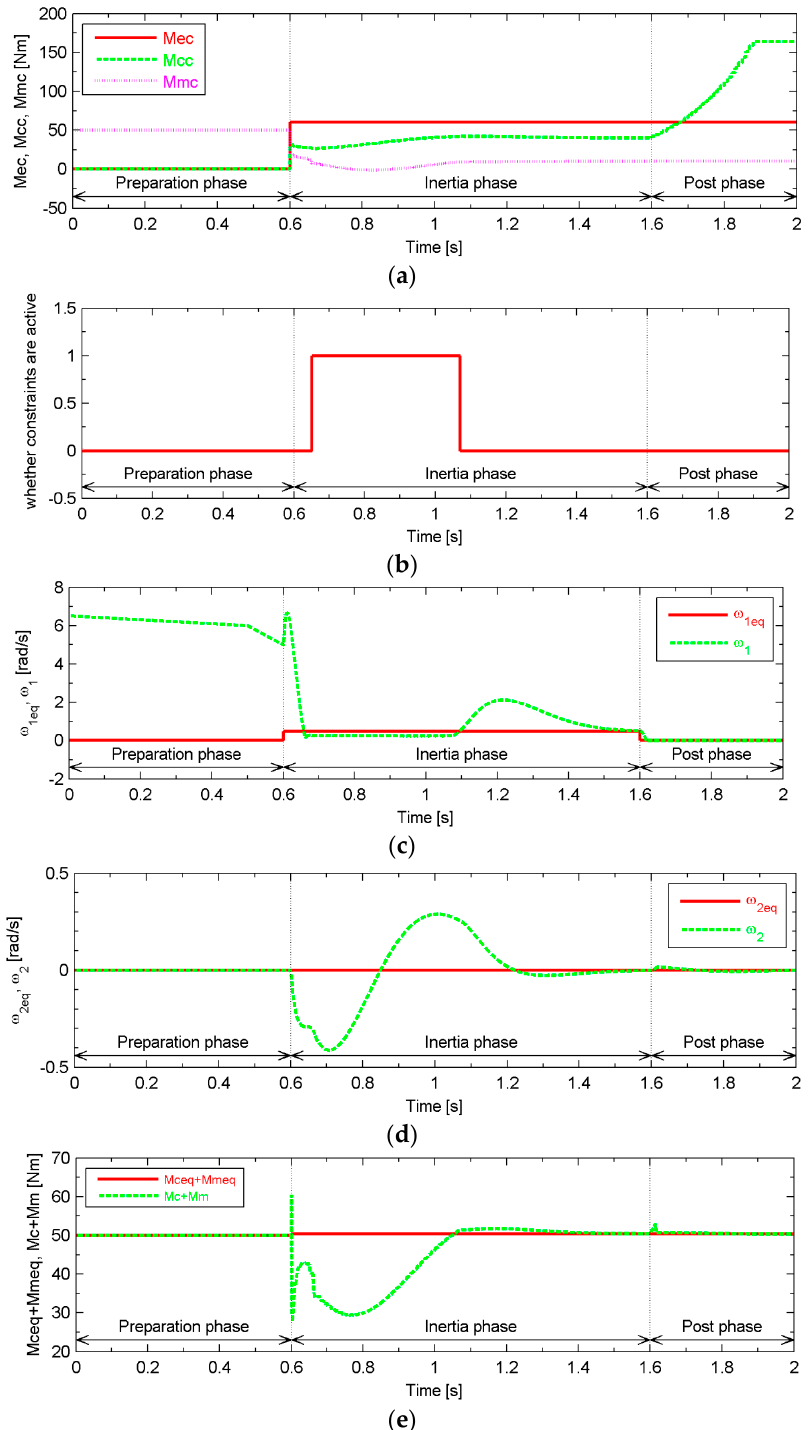
Figure 9. Performance in nominal conditions with a 1 = a 2 = 0.9, N 1 = N 2 = 5, Q 1 = I 3 × 3 and R = I 2 × 2 . ( a ) Engine output torque command M ec , clutch torque command M cc and motor output torque command M mc ; ( b ) Conditions of the constraints; ( c ) Equilibrium state of the clutch sliding speed ω 1 eq and clutch sliding speed ω 1 ; ( d ) Equilibrium state of the time derivative of torsion of the axle shaft ω 2 eq and time derivative of torsion of the axle shaft ω 2 ; ( e ) Torque demanded by the driver M ceq + M meq and torque supplied by the hybrid power source M c + M m